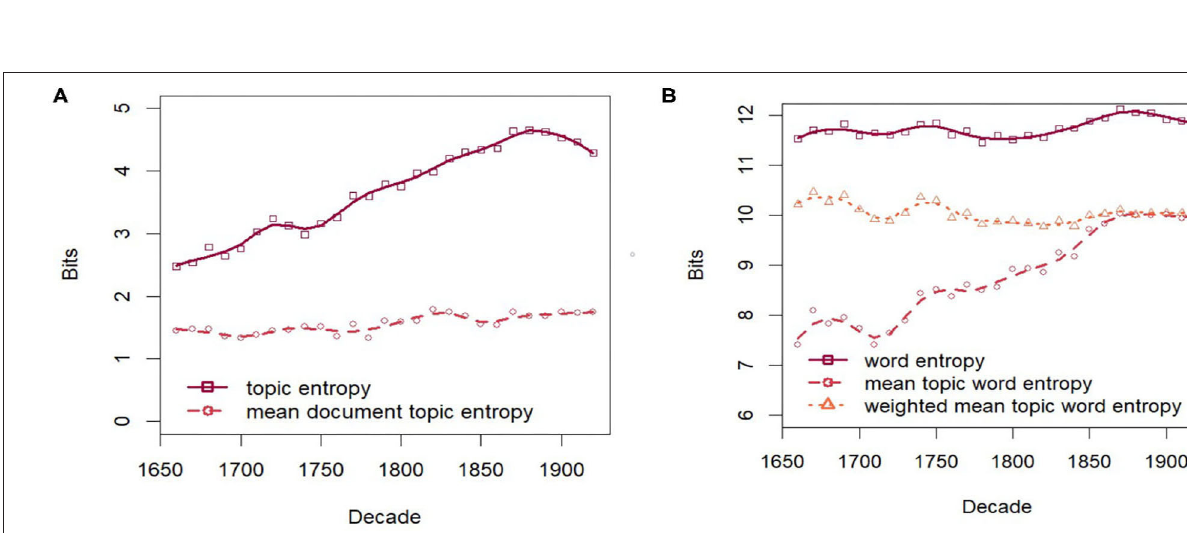
Frontiers in Artificial Intelligence |